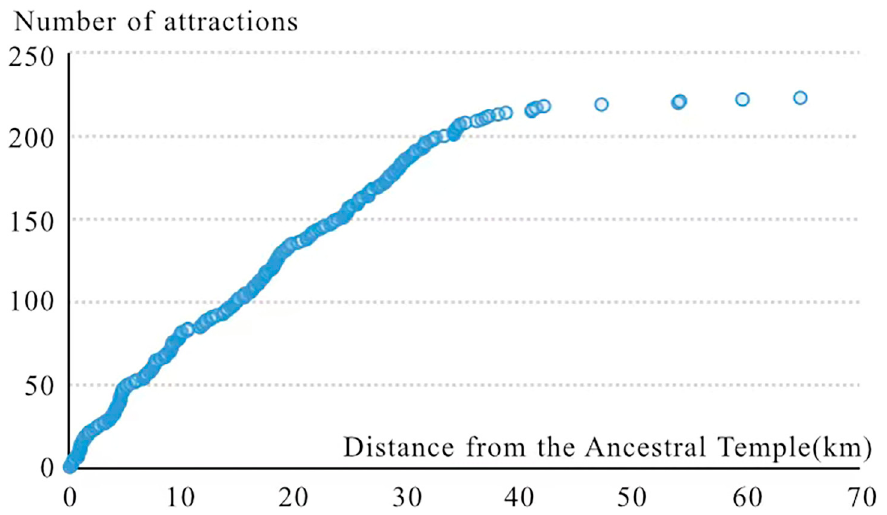
Figure 3. Number of attractions with